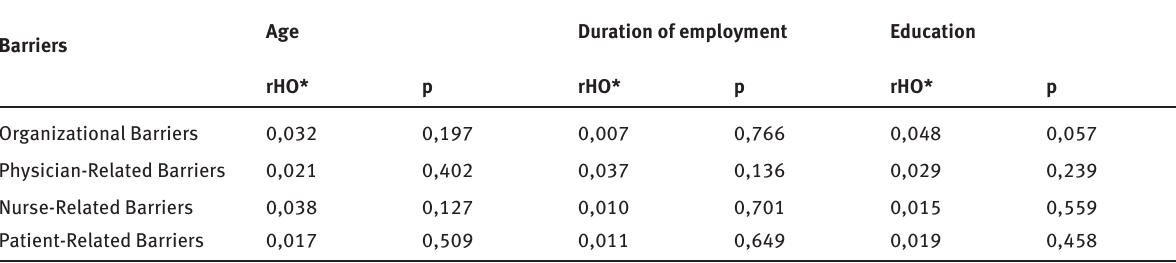
Patient-Related Barriers *Spearman rank order correlation